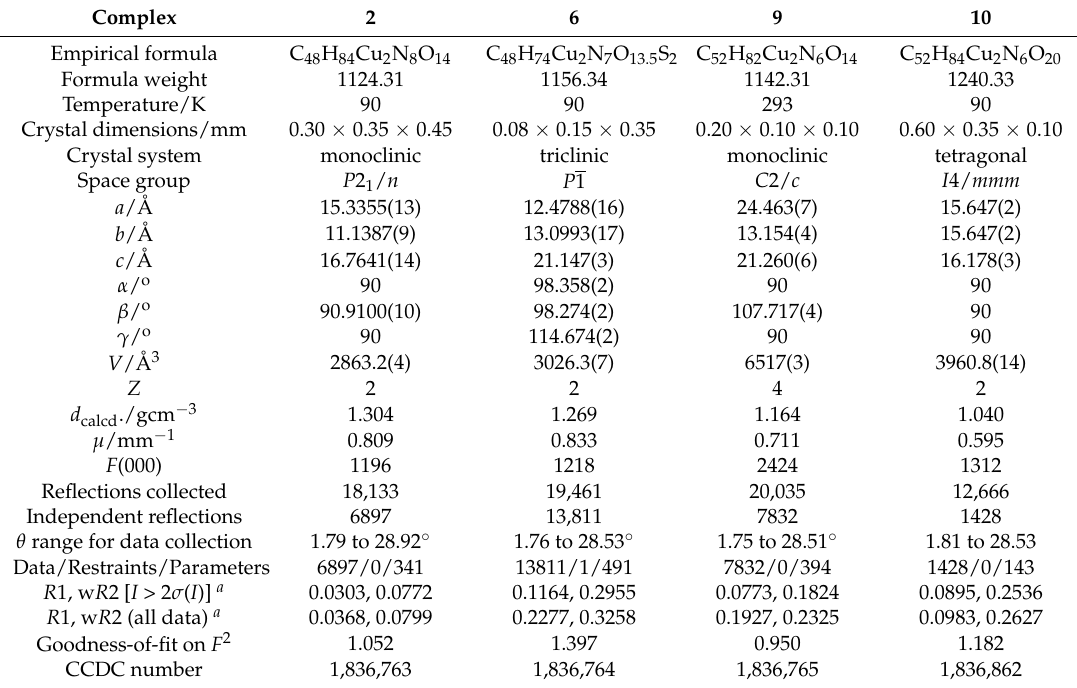
Table 5. Crystallographic data for 2 , 6 , 9 , and 10 .